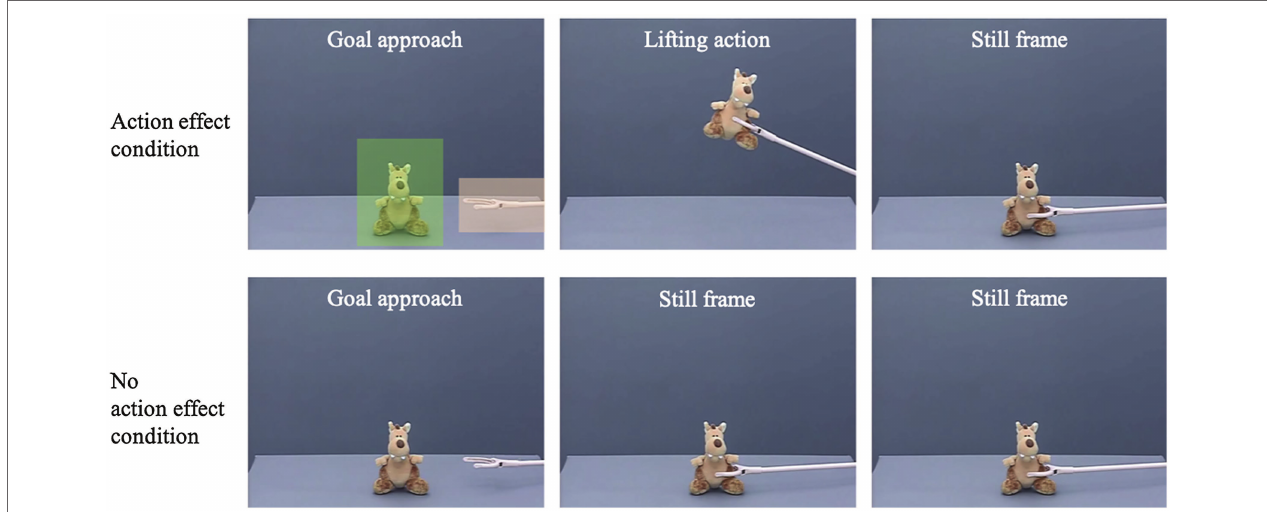
FIGURE 1 | Still frames of the stimulus videos in the action-effect condition (upper row) and the no-action-effect condition (lower row). The two squares in the first picture depict the areas of interest (AOIs) used for data analysis. The squares were not visible during the